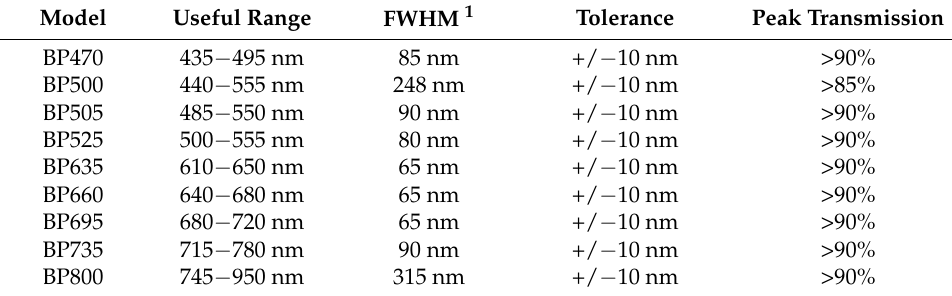
Table 2. Specifications of the band-pass filter used by the system.